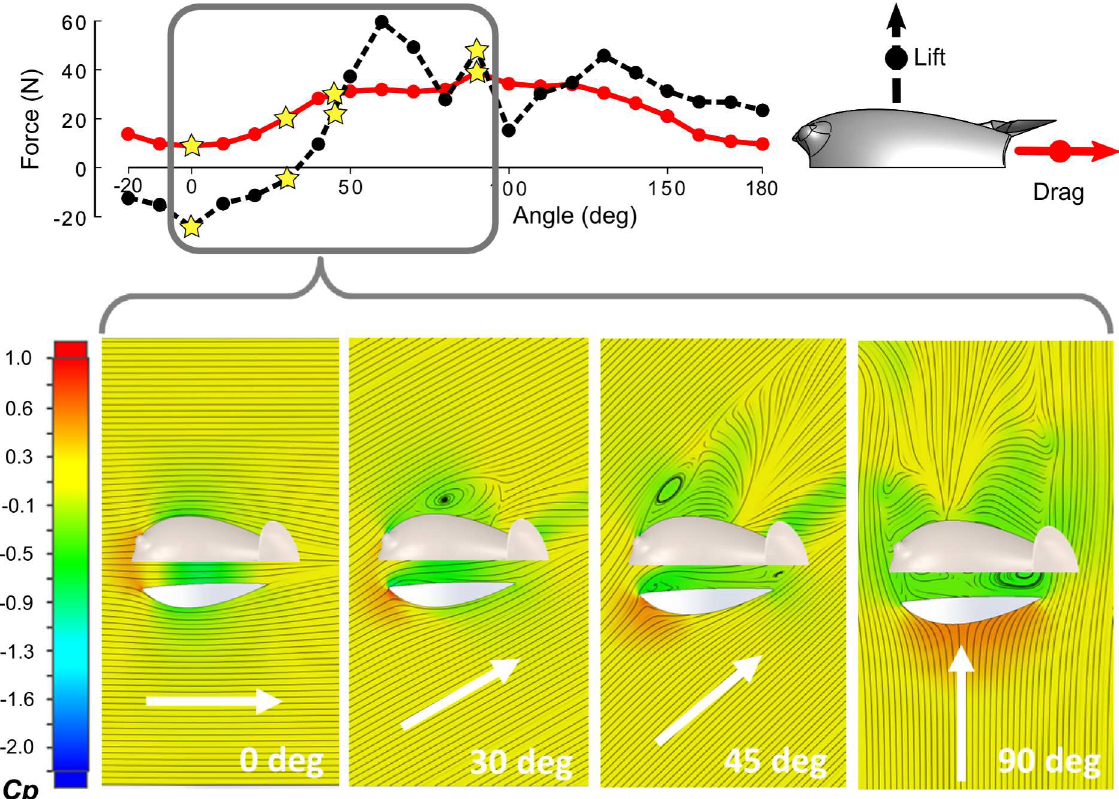
Fig 8. Net drag and lift forces for the Model A tag in off-axis 5.6 m/s flow. Simulationresults for four orientations(0˚, 30˚, 45˚ and 90˚) with the correspondingstream lines and color map of the resulting pressure field acting on a transverse plane parallelto the